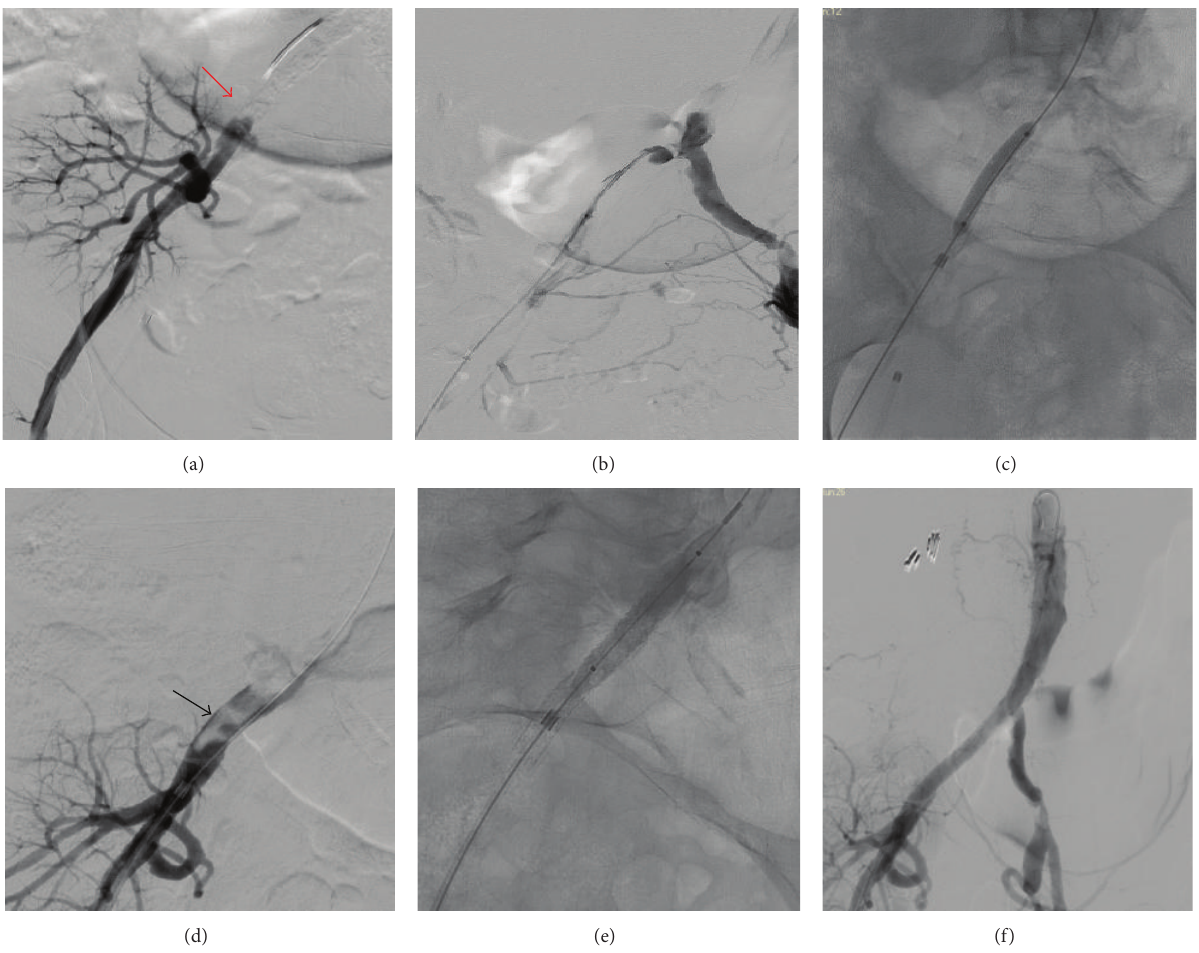
Figure 2: Aortoiliac and femoral angiogram showing complete occlusion (red arrow) of the right common iliac artery proximal to the kidney allograft anastomosis (a). Collaterals from the left iliac and femoral arteries feeding right-sided vessels below the occlusion (b). Balloon angioplasty of the right common iliac artery (c). Partial recanalization and visible floating thrombus (black arrow) of the right common iliac artery after balloon angioplasty (d). Balloon assisted covered stent (iCast) deployment and postdilation of the stent (e). Postintervention angiogram shows normal flow to the kidney allograft